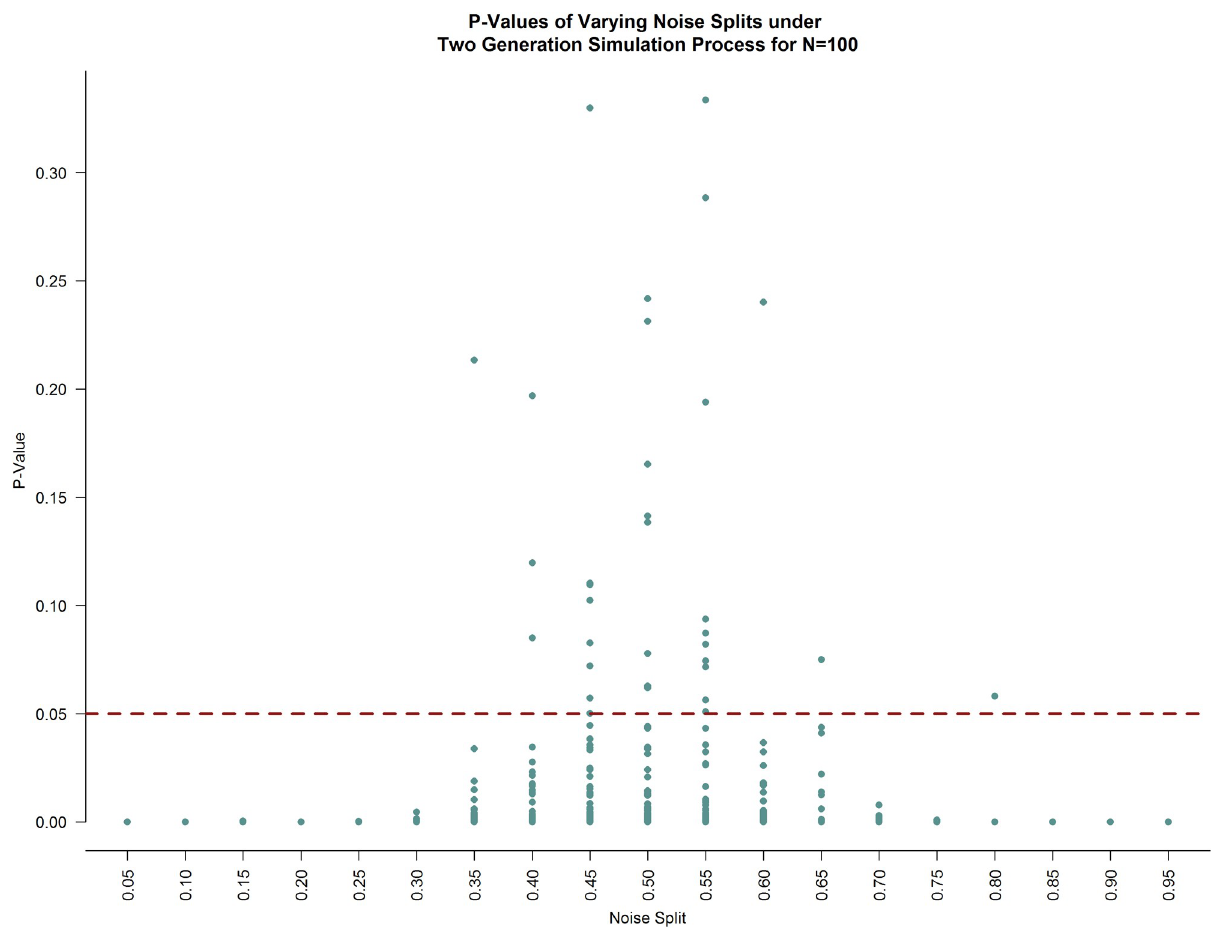
Fig 6. P-values under varying noise population allocations under a two generation simulation process. At each noise allocation, 100 iterations were conducted. The red dashed line is at the nominal p-value of 0.05. Any point above this red line is a false negative while any points below this red line are true positives. The highest proportion of false negatives occurs at noise splits at or surrounding 0.5, as expected.